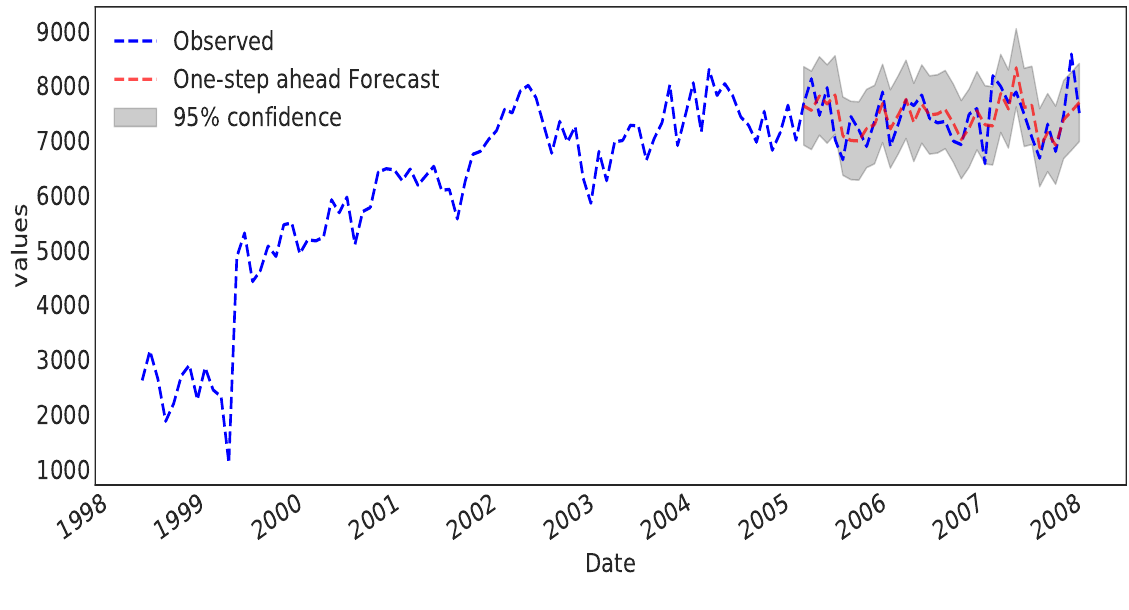
Figure 3. Comparison between the observed and predicted values (one-step-ahead result) for the SARIMA model on a crime dataset.